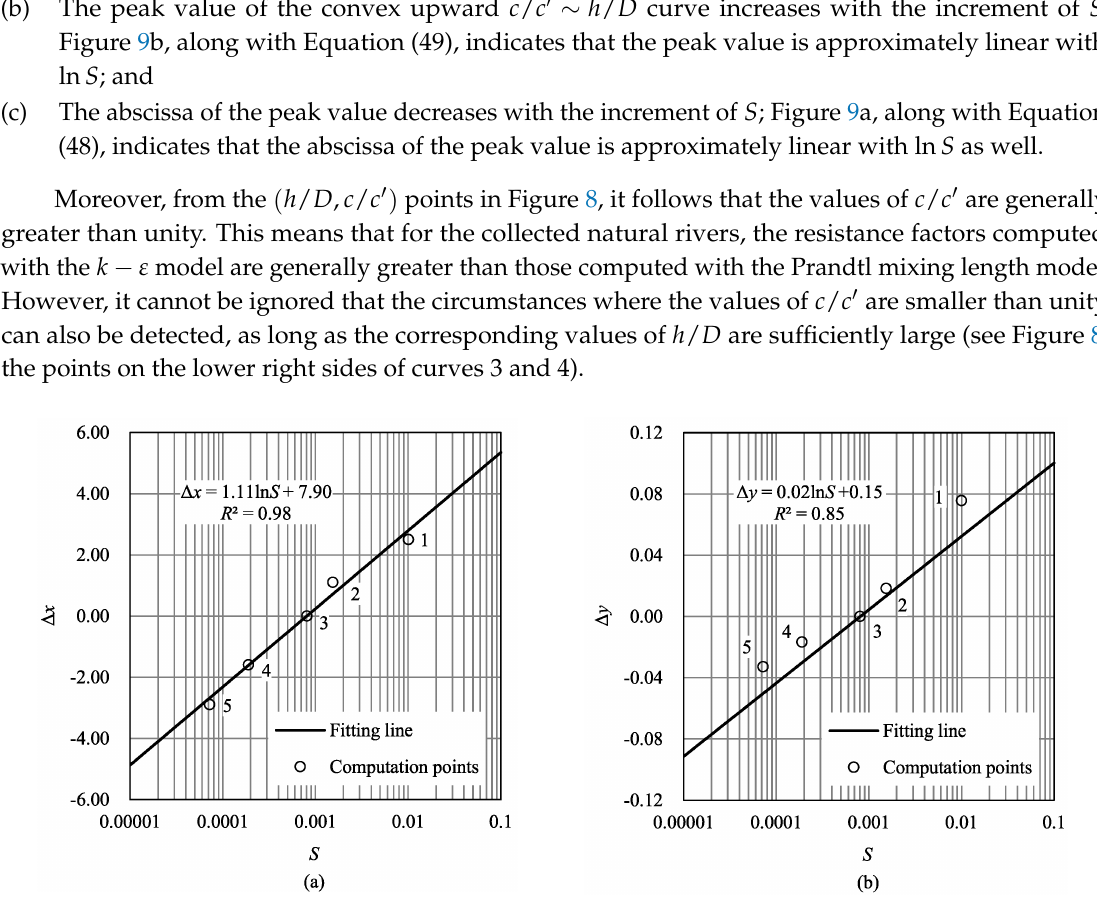
Figure 9. The relation of translation parameters ( a ) Δ x and ( b ) Δ y to the bed slope S.